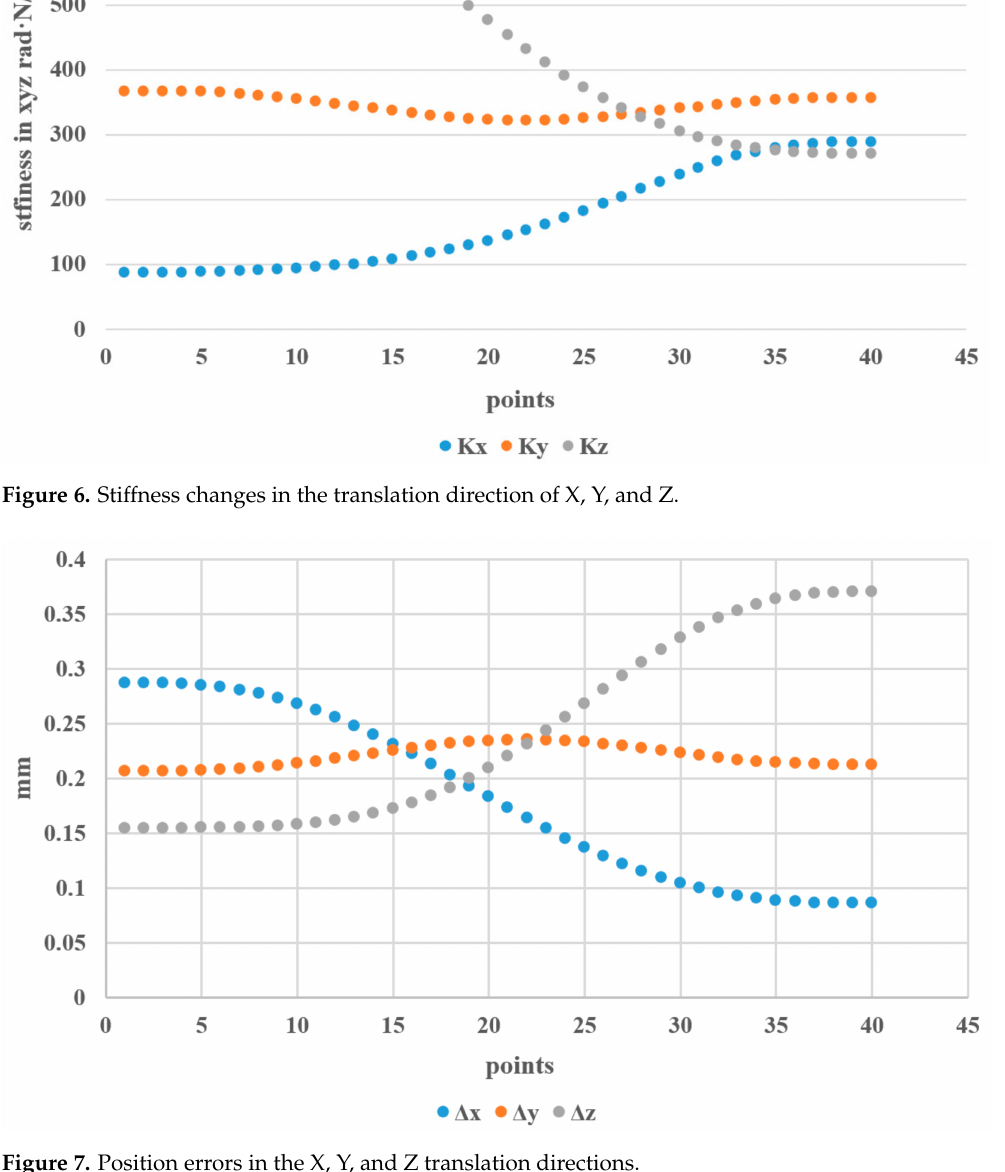
Figure 7. Position errors in the X, Y, and Z translation